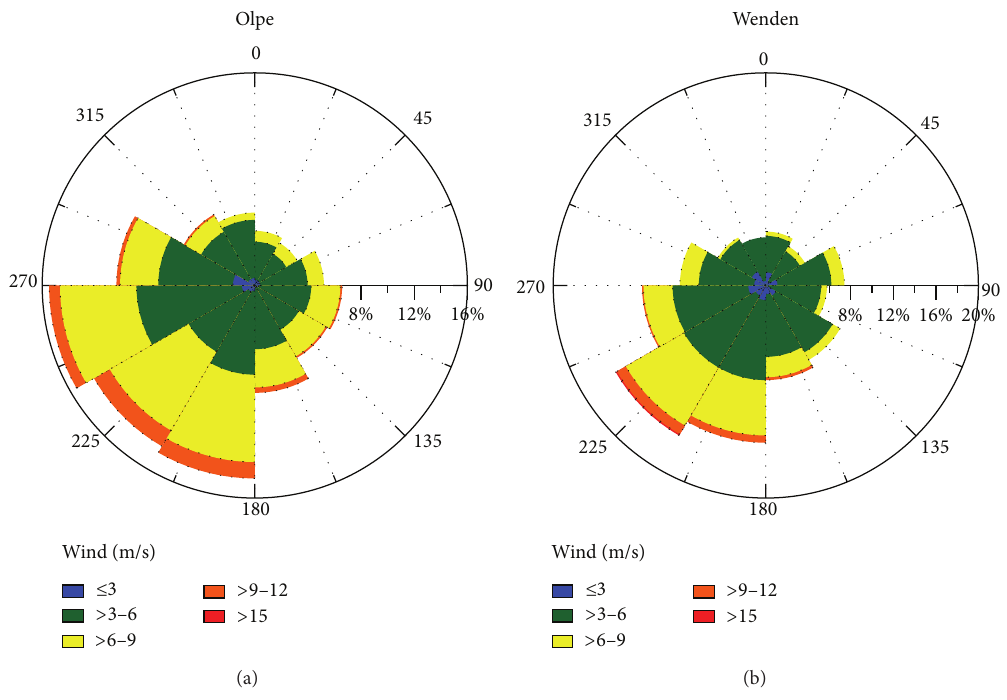
Figure 7: Average wind conditions at the sites Olpe and Wenden during the period from January 2004 through January 2008.